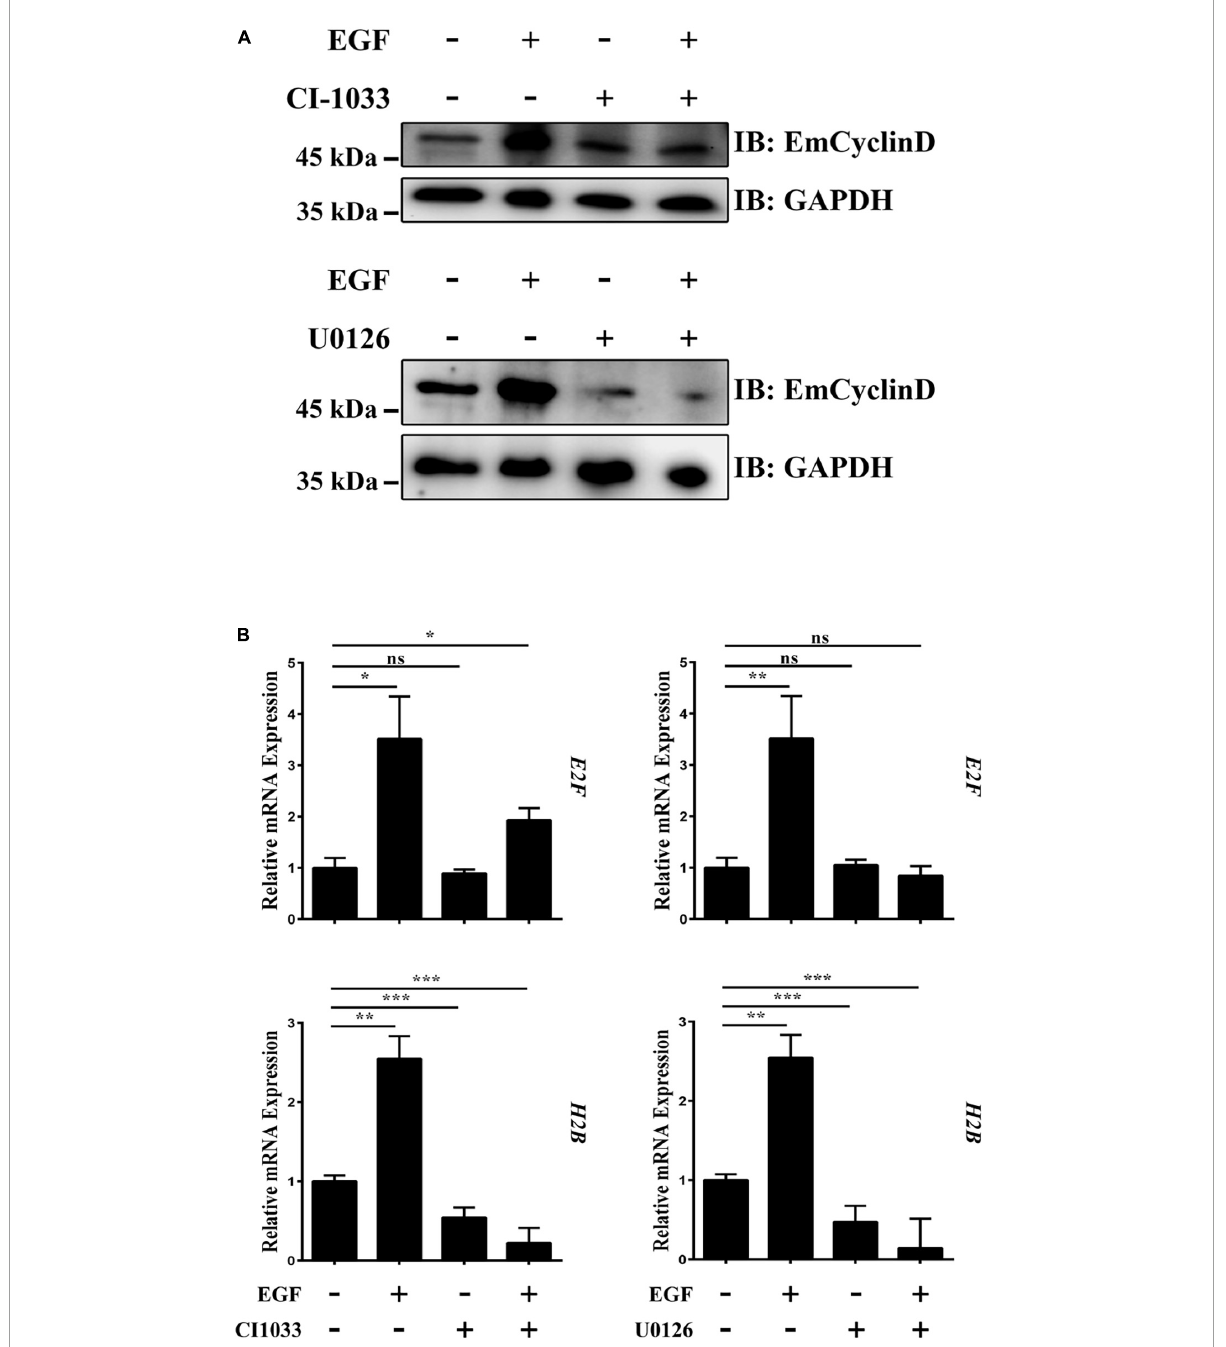
FIGURE5 The EGFR-ERK pathway regulates EmCyclinD and downstream factors expression in E. multilocularis. (A) CI-1033 and U0126 inhibit EGF-stimulated EmCyclinD expression in E. multilocularis . Metacestode vesicles were treated with 10 µ M CI-1033 or 40 µ M U0126 for 3 h and then stimulated with EGF for 45 min. (B) mRNA expressions of EmCyclinD and S-phase related factors after CI-1033 or U0126 treatment. Data are shown as mean ± SD . * P < 0.05, ** P < 0.01, *** P < 0.001. ns, P > 0.05.